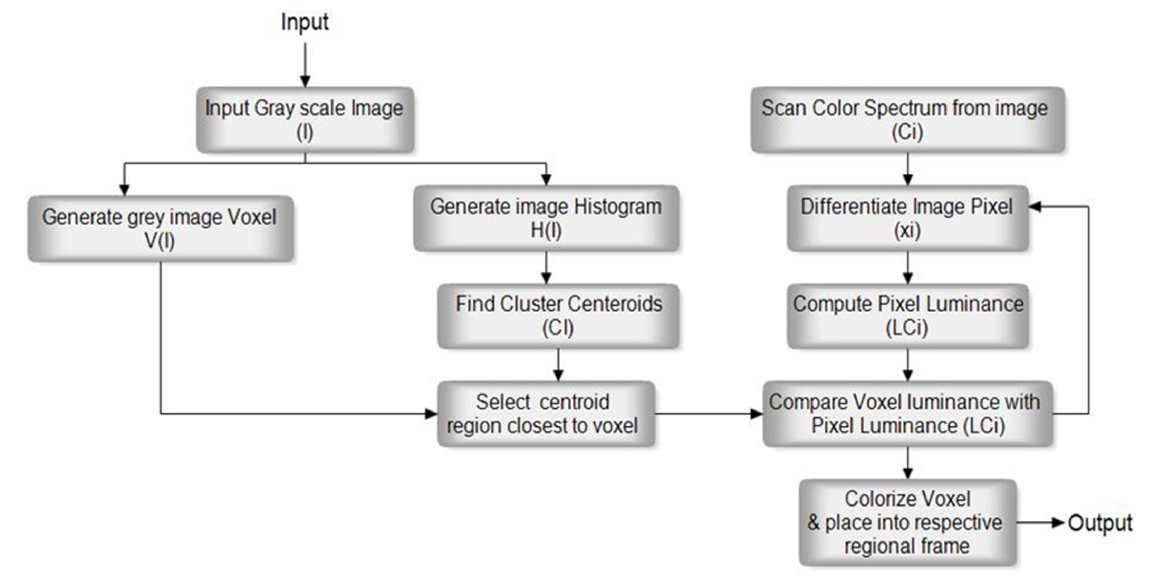
Figure 5. Proposed grayscale colorization method.